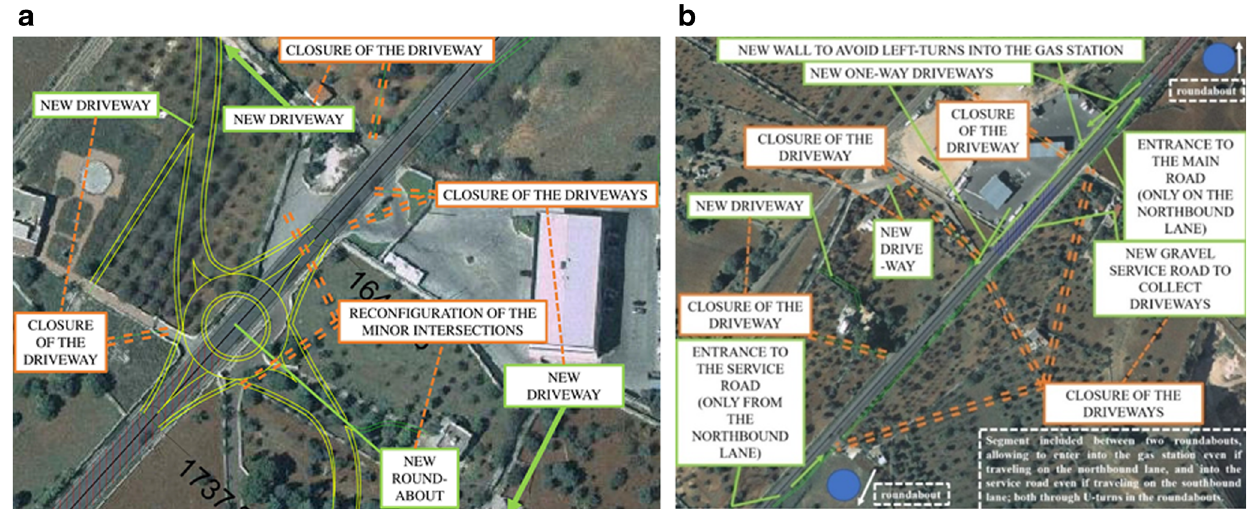
Fig.12 Possible solutionsofdriveways/minorintersection-related issues.SitePP2: a exampleofroundabout for enhancing minor intersection geometry, b example of service roads and driveways recollection through minor